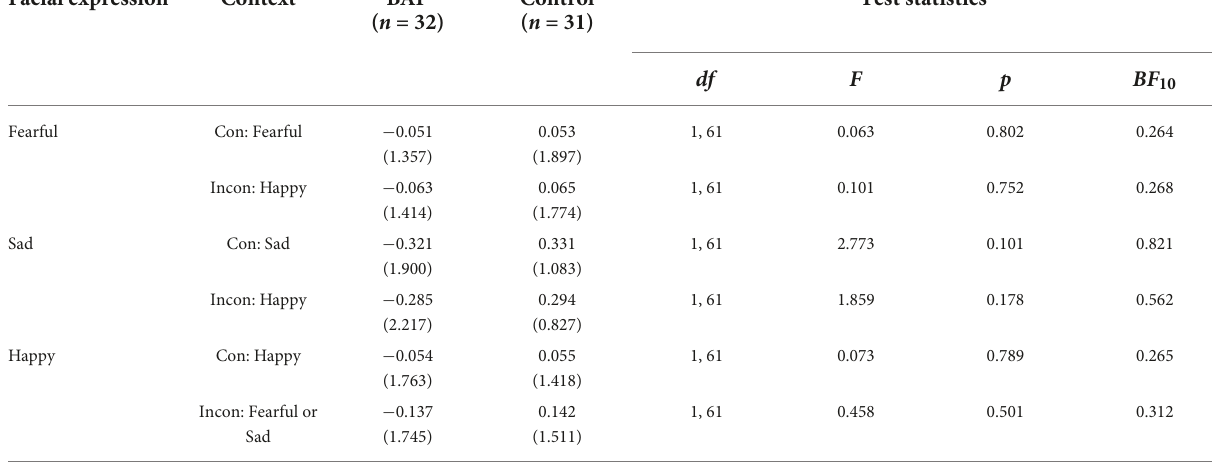
TABLE 4 Mean (SD) of sensitivity under each emotion and congruence condition for the groups. Facial expression